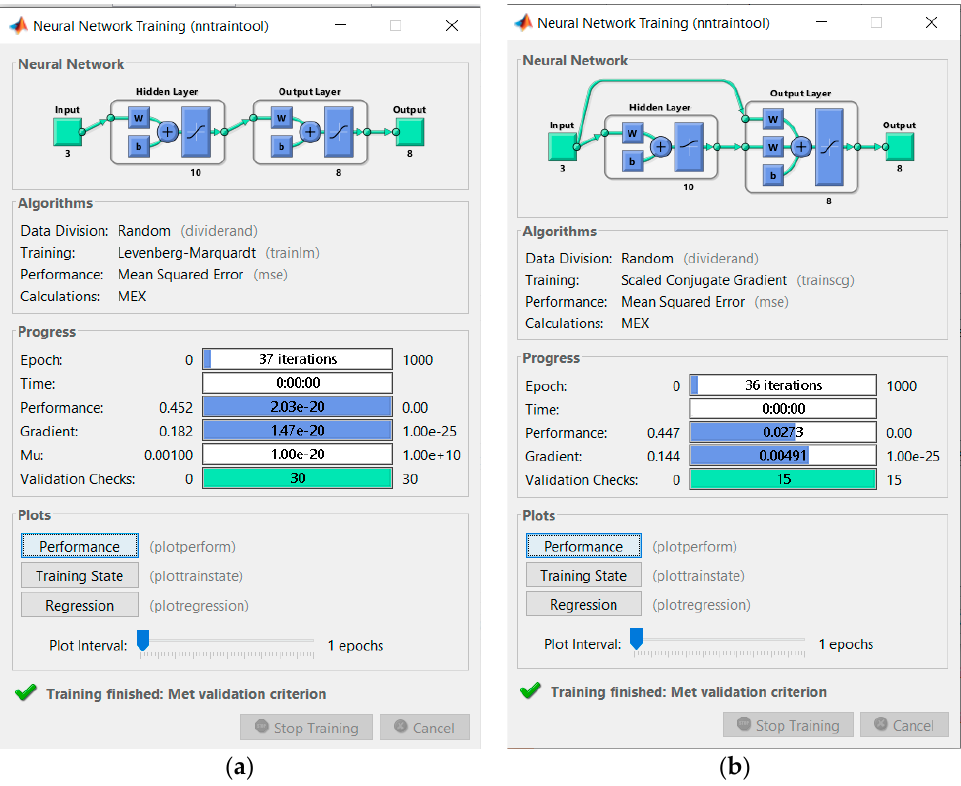
Figure 4. Training neural classifiers in the Deep Learning Toolbox of MATLAB: ( a ) feed-forward back-propagation ANN; ( b ) cascaded-forward back-propagation ANN.